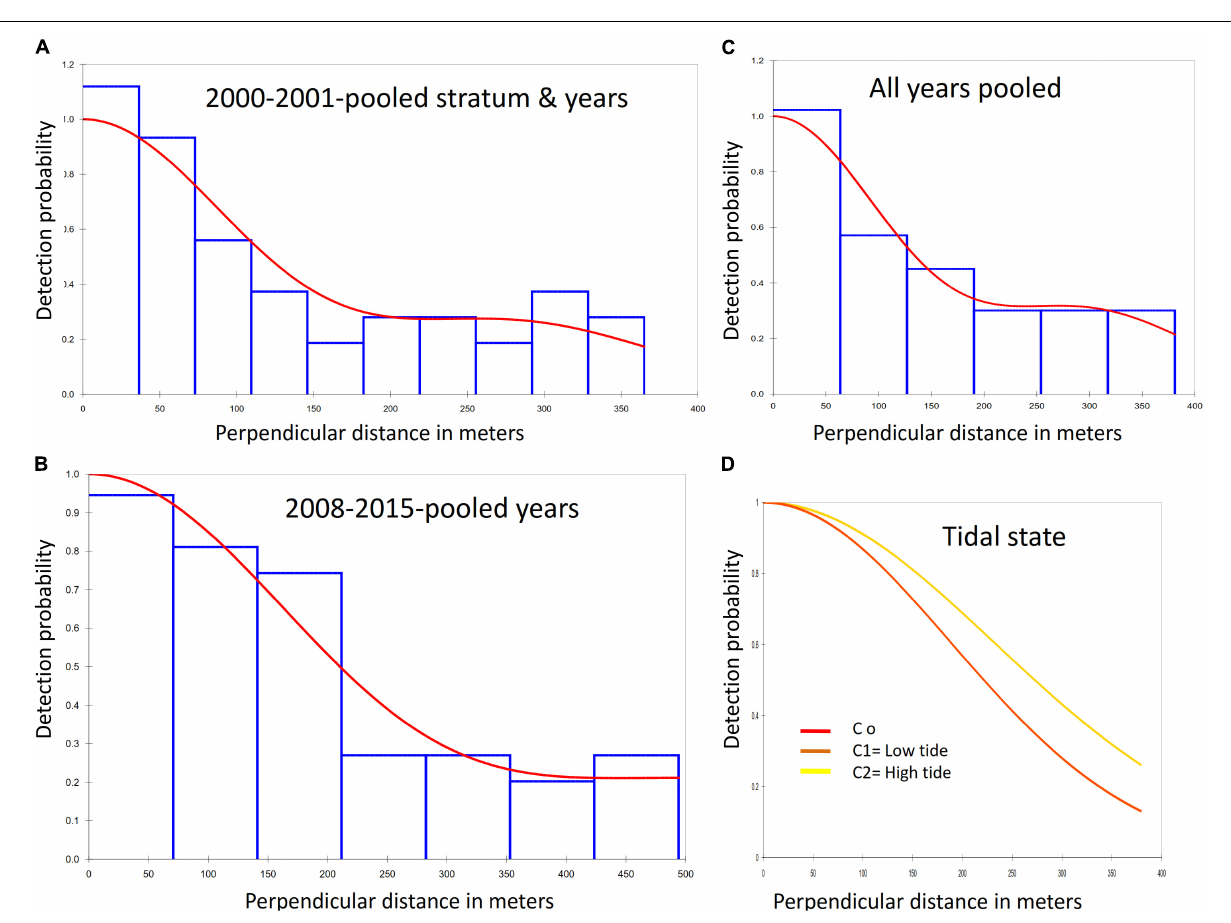
group sizes were used in the chosen models as the P -value of size-bias regression tests were greater than the specified significance level of